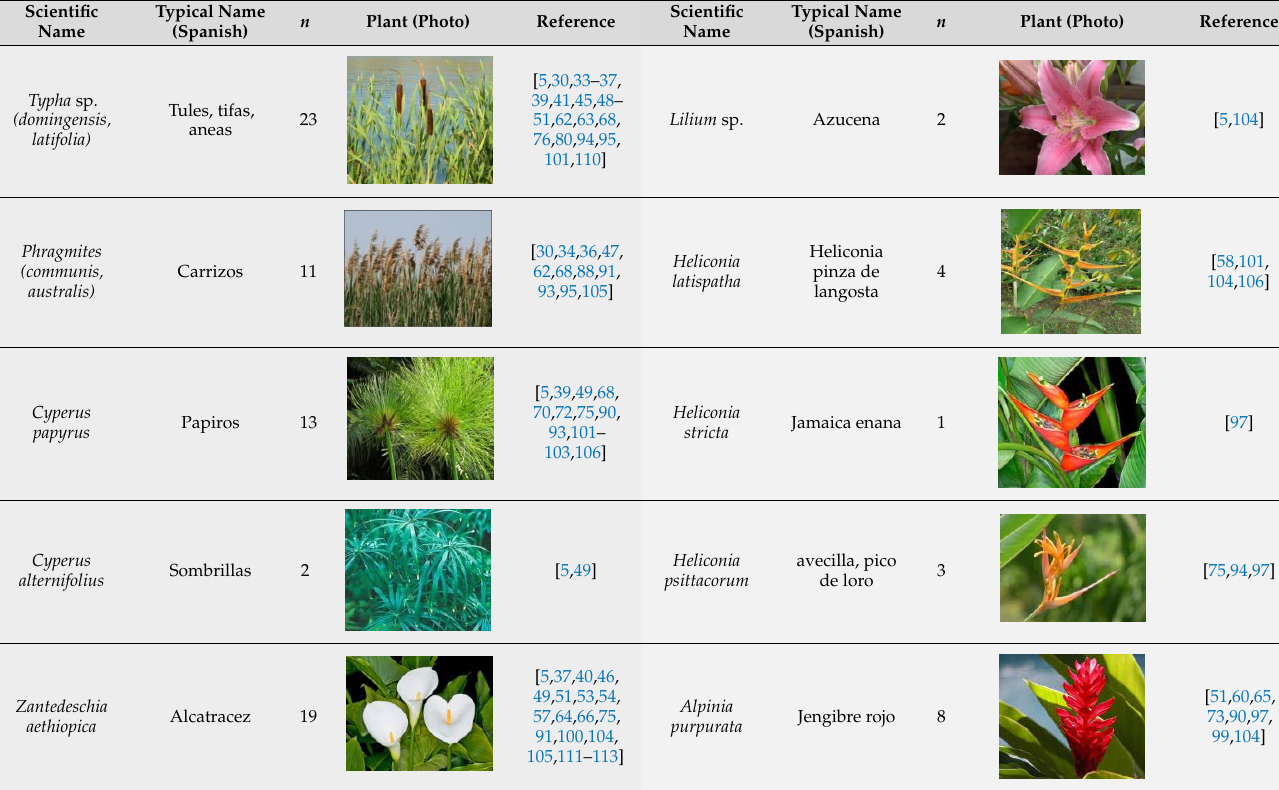
Table 2. Plant species reported in Mexican CWs.